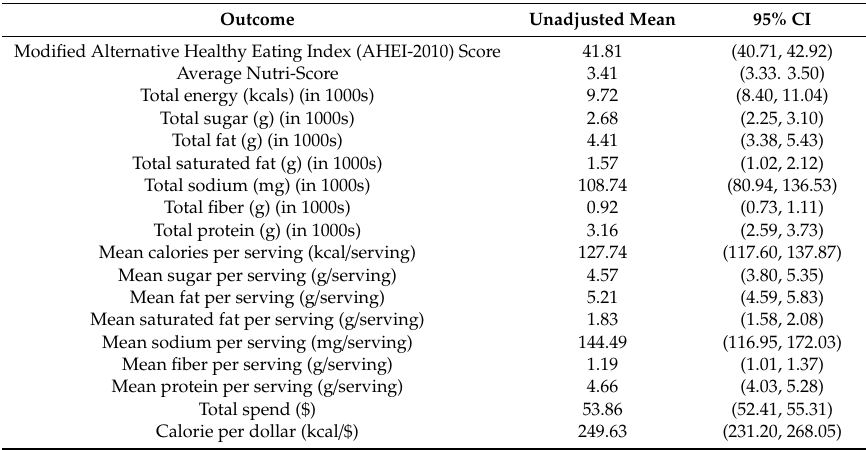
Table 2. Dietary characteristics of food purchases in the Control condition ( N = 147).